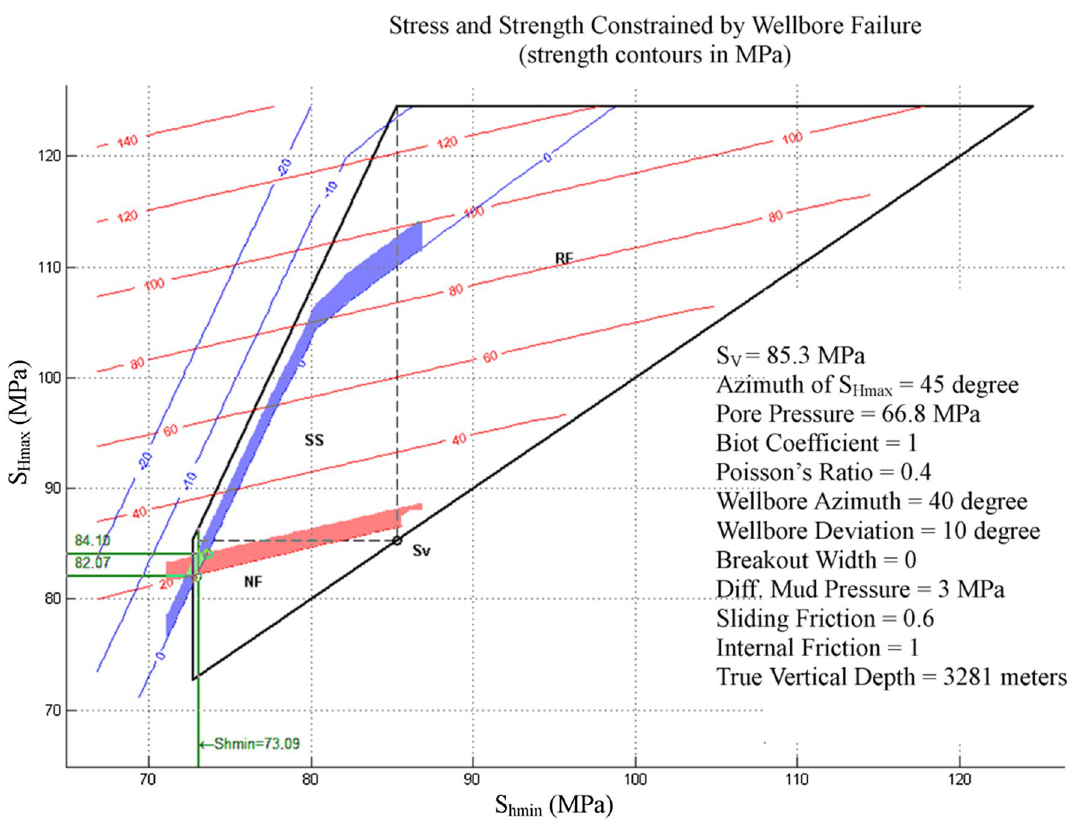
Fig. 4 Stress polygon based on the Mohr–Coulomb failure criterion for Marun 42